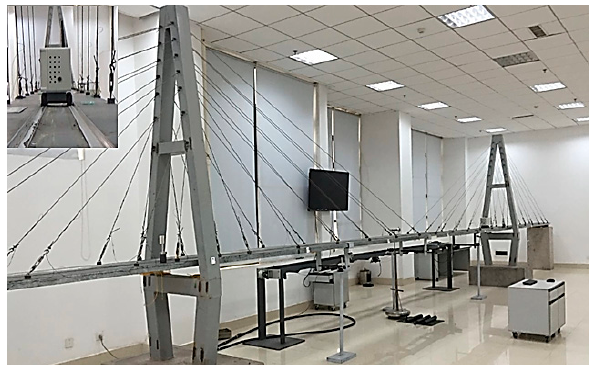
Figure 1. Experimental platform for testing continuous deflection.